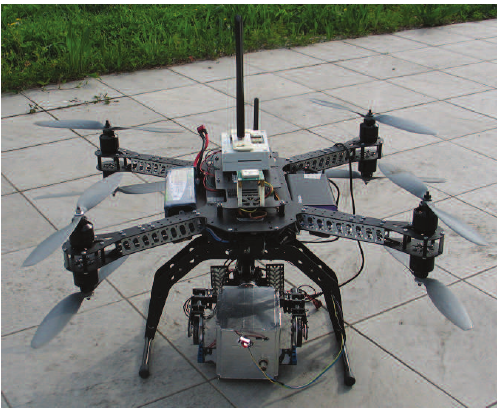
Figure 3. UAV equipped with the CdZnTe gamma-ray detector (mounted at the